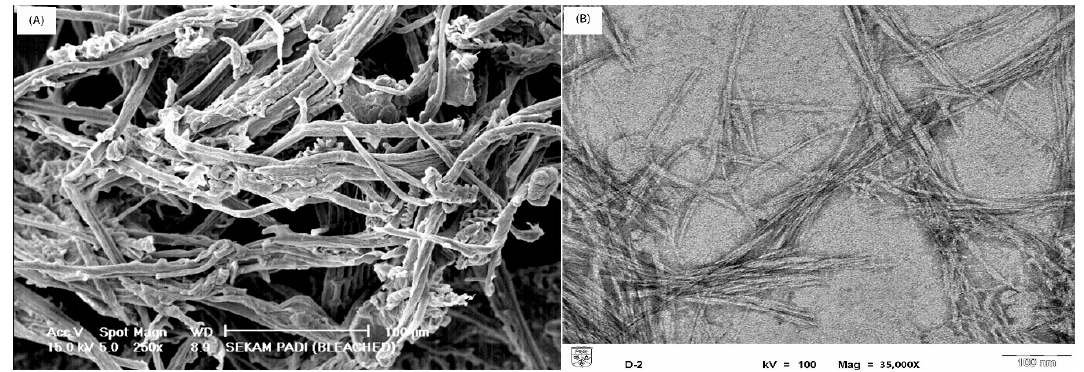
Figure 2. ( A ) Scanning electron microscope (SEM) image of pristine cellulose fibers and ( B ) transmission electron microscope (TEM) image of CNCs.